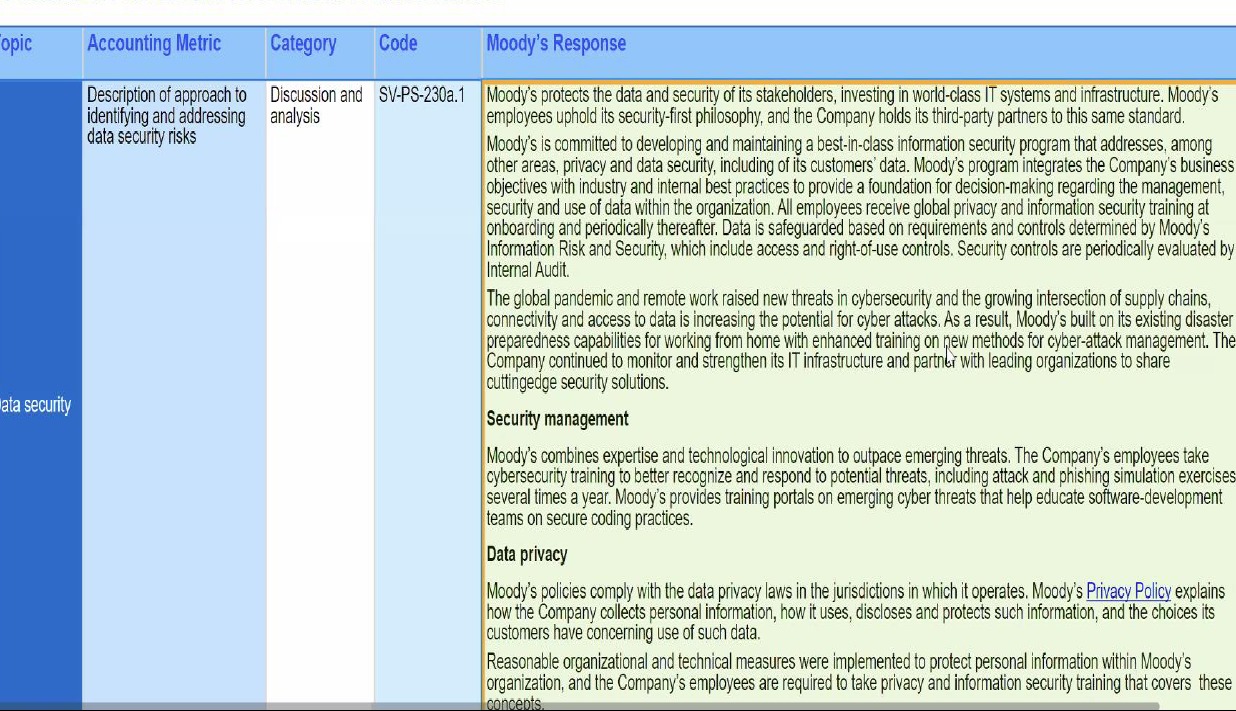
Figure 3. Sustainability disclosure sample: data security.